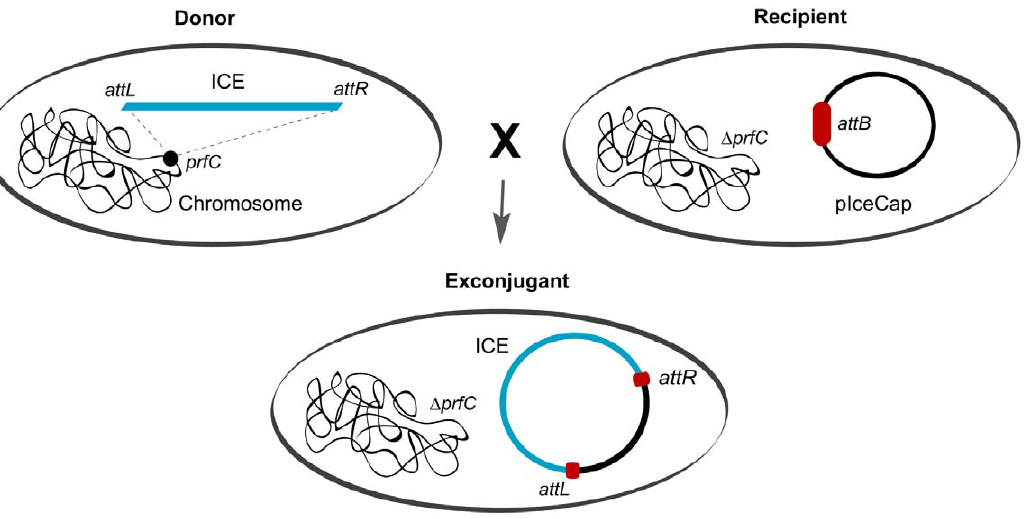
Figure 1. Schematic of the ICE capture system. Conjugation between a donor strain bearing a chromosomal ICE and a D prfC recipient strain harboring pIceCap, which contains attB , yields exconjugants that contain the transferred ICE integrated into pIceCap. Exconjugants were selected for using a marker on pIceCap and on the ICE. attR and attL represent the right and left ICE-chromosome junctions.